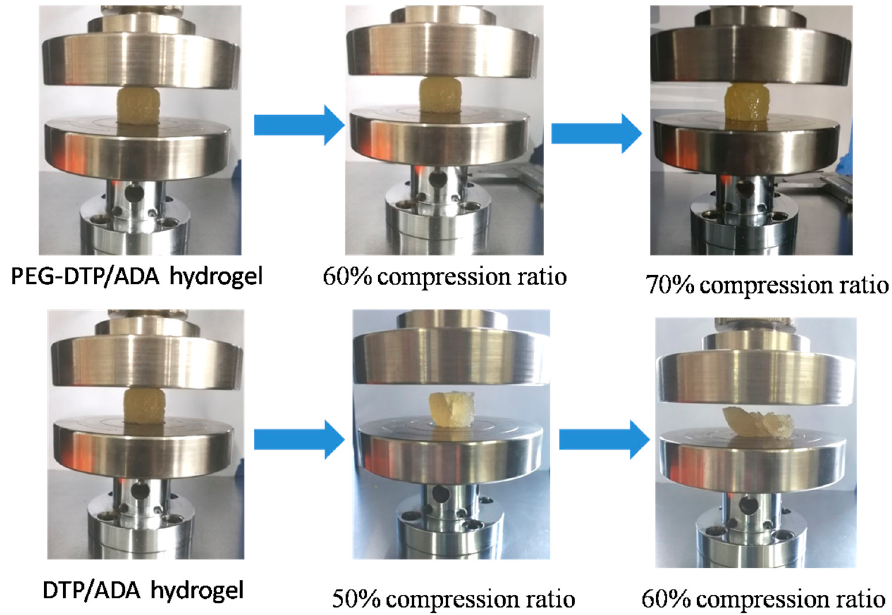
Figure 3. Compression performance of the PEG-DTP/ADA hydrogel and the DTP/ADA hydrogel.